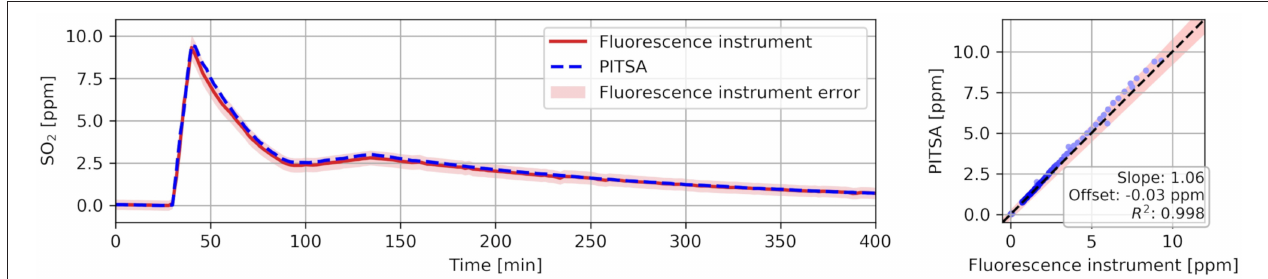
FIGURE 13 | Left : Parallel measurements of the PITSA and the AF 20M fluorescence monitor during an SO 2 injection event in the atmospheric simulation chamber. Right : Corresponding scatter plot. Darkness of points represents the data point density. The red shaded area indicates the uncertainty of the AF 20M, as estimated from earlier chamber